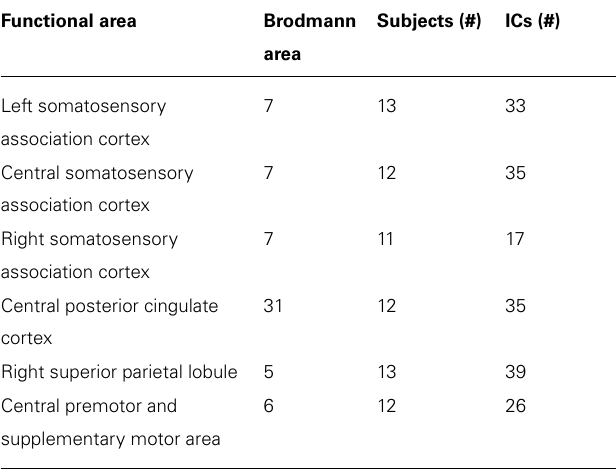
spectral power shifts temporally linked to stimulus